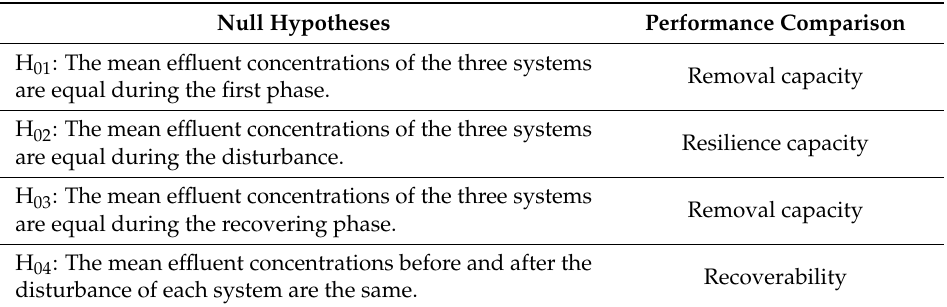
Table 1. Four null hypotheses with the relevant objectives of this study for each of the following variables: BOD 5 , COD, TN and